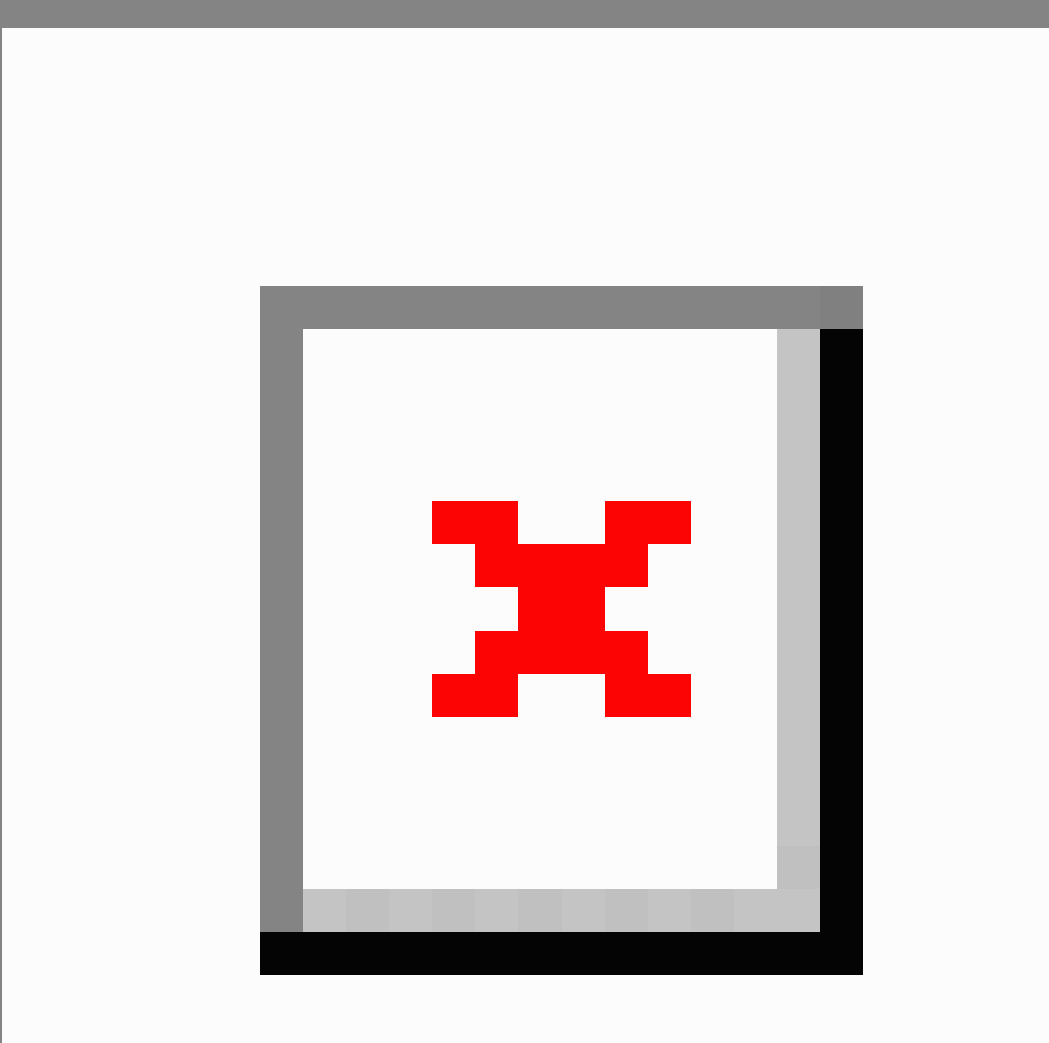
Figure 4. In version 3, the bar on the left side combines amount and intensity of steps. The DPA goal is met when the vertical stripe (representation of current activity status) is kept in the rising rectangle at all times until the green area is reached. Absolute number of steps and current advice on DPA progress are also shown (pilot study